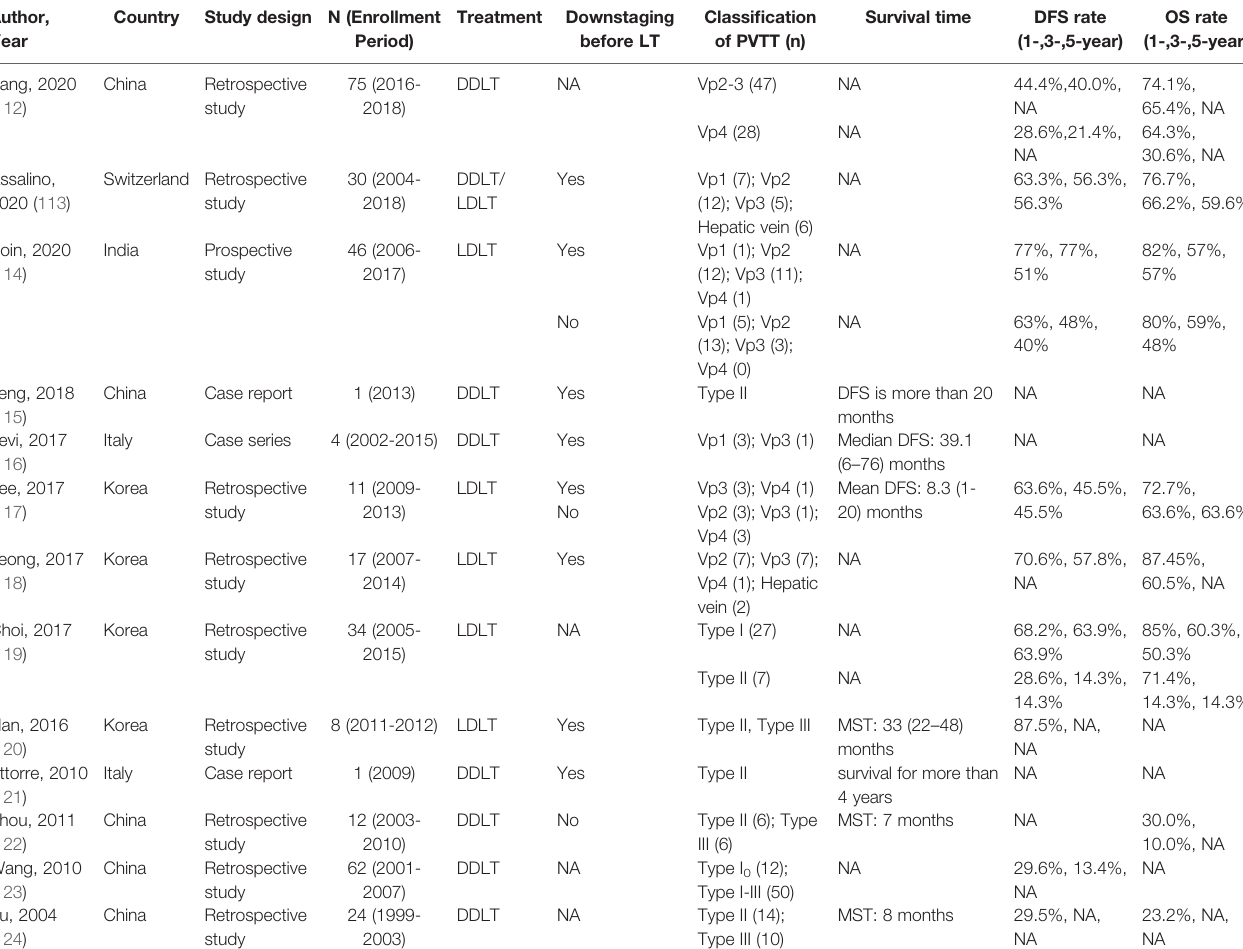
TABLE 2 | Liver transplantation for HCC patients with